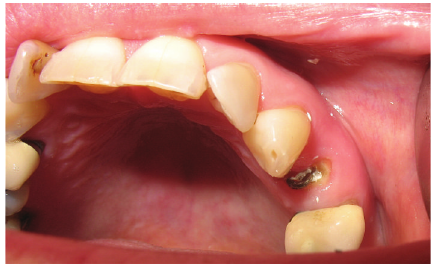
Figure 3: J hook cemented in the root canal is attached by an elastic chain to .018 (cid:2)(cid:2) SS sectional wire with an o ff set for orthodontic trac- tion.